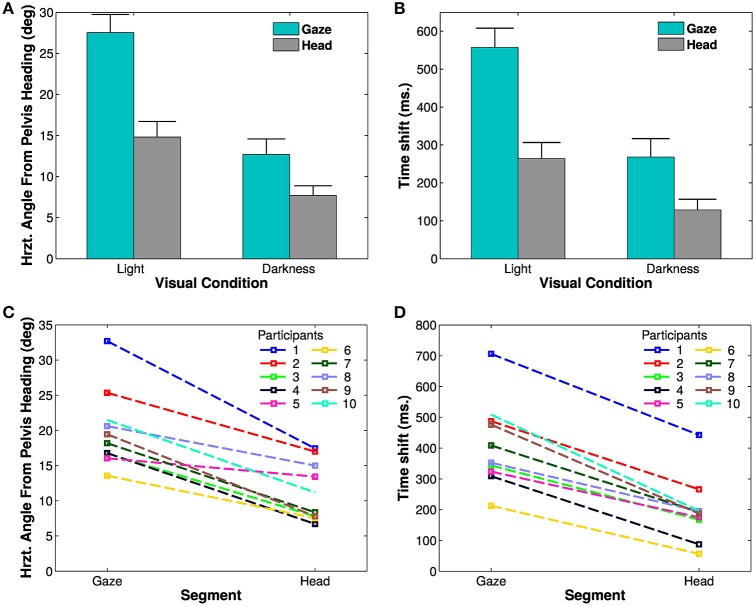
Spatial and temporal anticipation of the body segments. (A,B) Averaged anticipations in both visual conditions are represented (left: in light, right: in darkness). All differences are statistically significant (significance threshold: p < 0.05). The vertical bars represent the between-participant standard deviation. (A) Spatial anticipation of gaze (blue) and head (gray) with respect to the tangent to the pelvis orientation. (B) Time shift of the different body segments with respect to the pelvis movement. (C,D) Average spatial anticipation (C) and time shift (D) of the body segments for each participant. Each color corresponds to one participant.